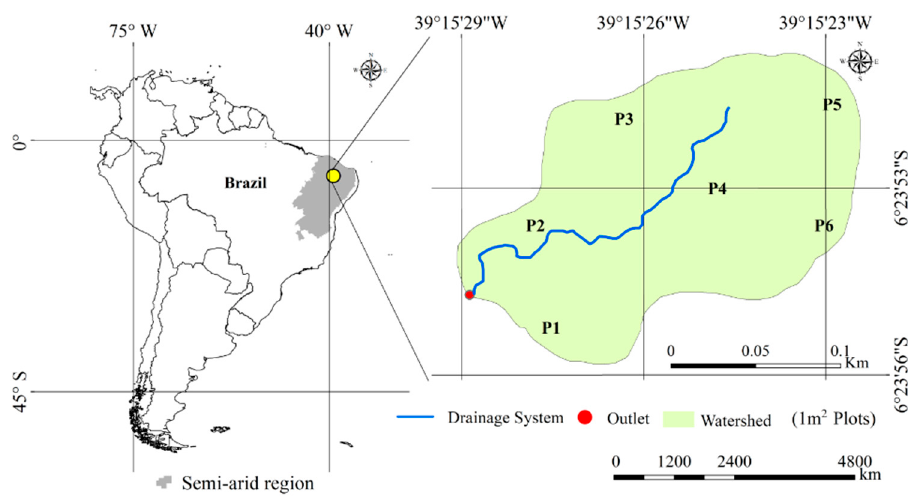
Figure 1. Study area